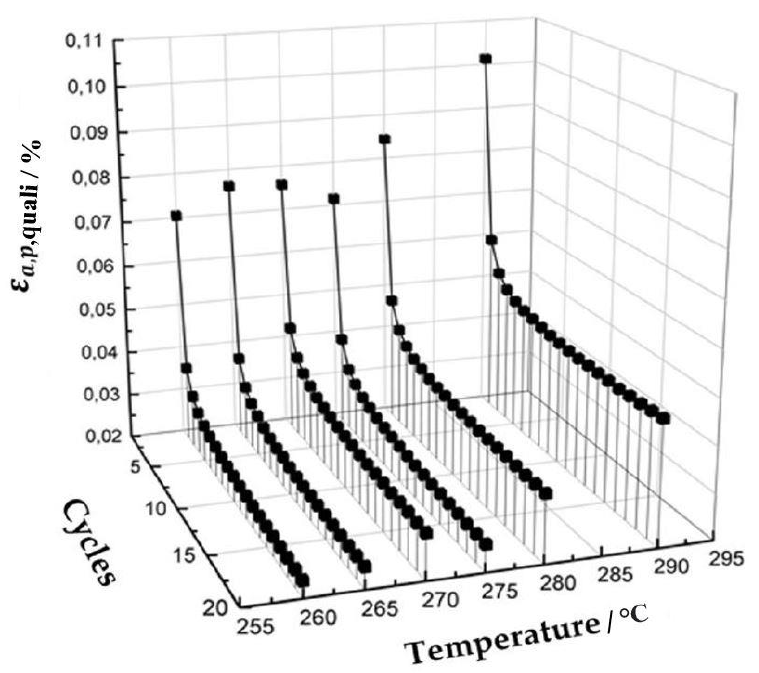
Figure 2. Development of the qualitative plastic strain amplitude ε a,p,quali at a constant stress amplitude of 1500 MPa and at 1 Hz for different temperatures. The ratio of ε a,p,quali in the first and 20th cycles was chosen to asses cyclic hardening.